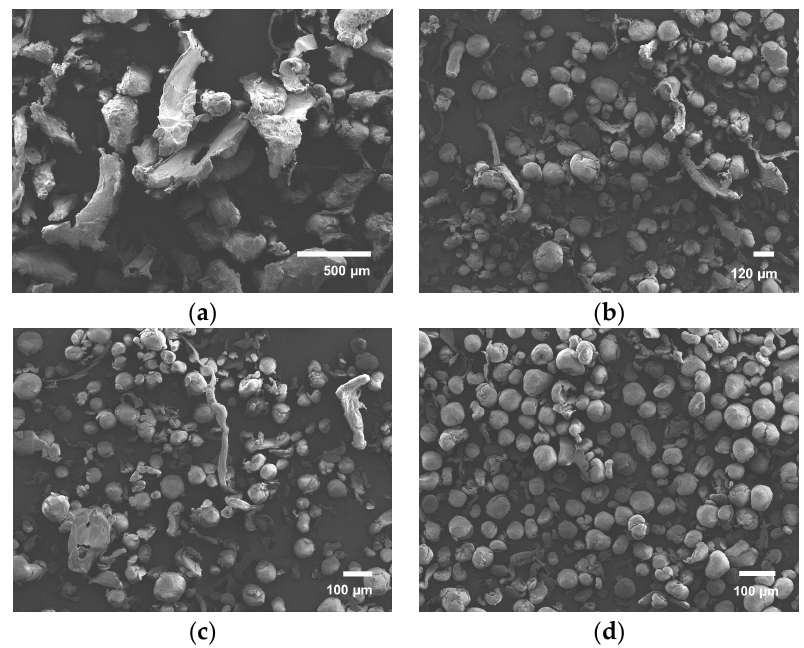
Figure 5. ( a ) Coarse powder by pulverization of pellets at 500 μ m; ( b ) First refinement step by pulverisation of coarse powder at 120 μ m; ( c ) Second refinement step by further pulverization of the refined powder until 80 μ m and ( d ) Final powder after additional sieving at 80 μ m.